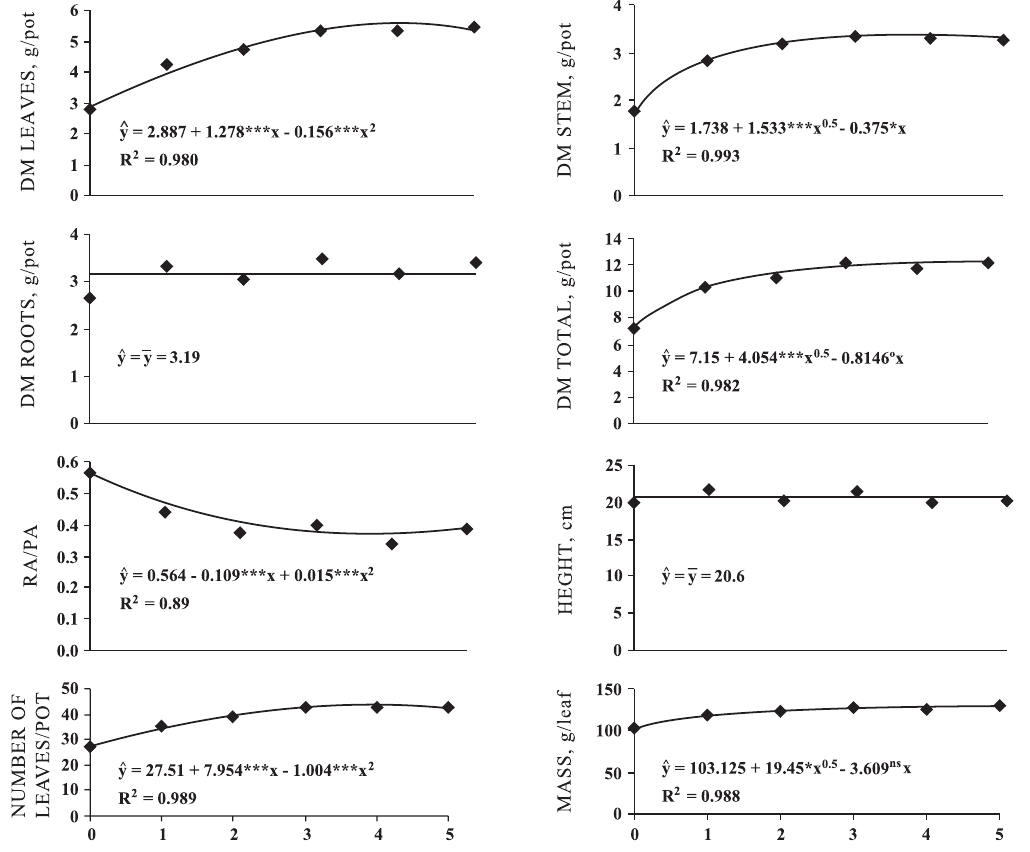
Figure 1. Production of leaf, stem, root and total dry matter; root-to-shoot ratio (R/AP); average stem height; number of leaves; and leaf weight in Epidendrum ibaguense at varying lime rates applied to the growth substrate. º, *,***: significant at 10; 5; 0.1 % and ns : not